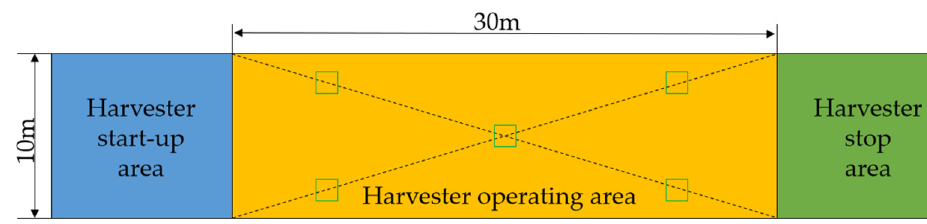
Figure 17. Experimental plot area division diagram.